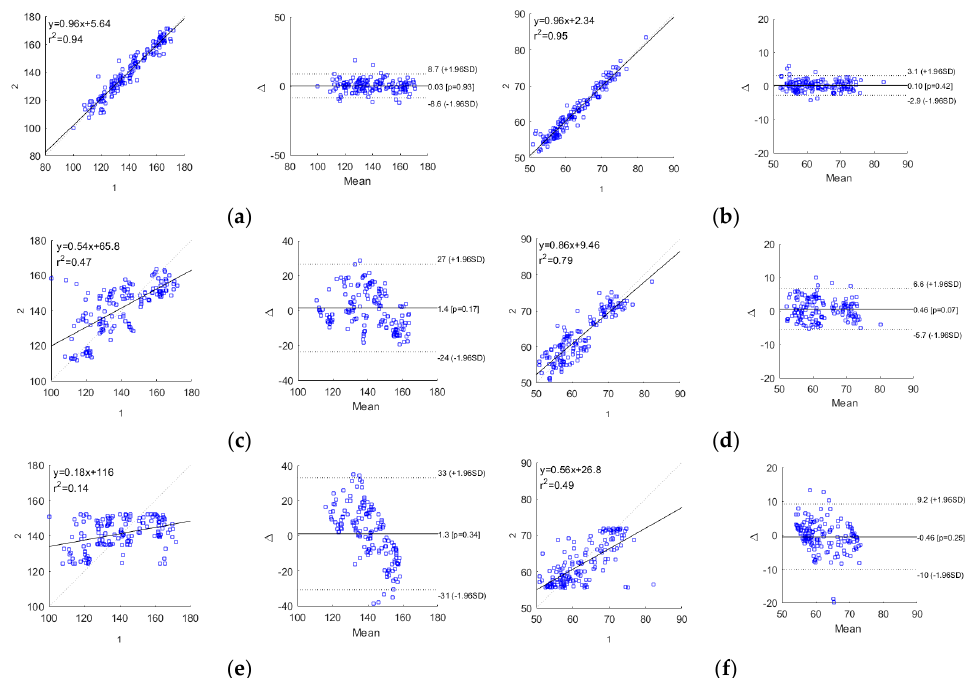
Figure 9. Correlation and Bland–Altman analysis. ( a ) GA-MIV-SVR SBP model. ( b ) GA-MIV-SVR DBP model. ( c ) Traditional MLR SBP model. ( d ) Traditional MLR DBP model. ( e ) PTTc-SVR SBP model. ( f ) PTTc-SVR DBP